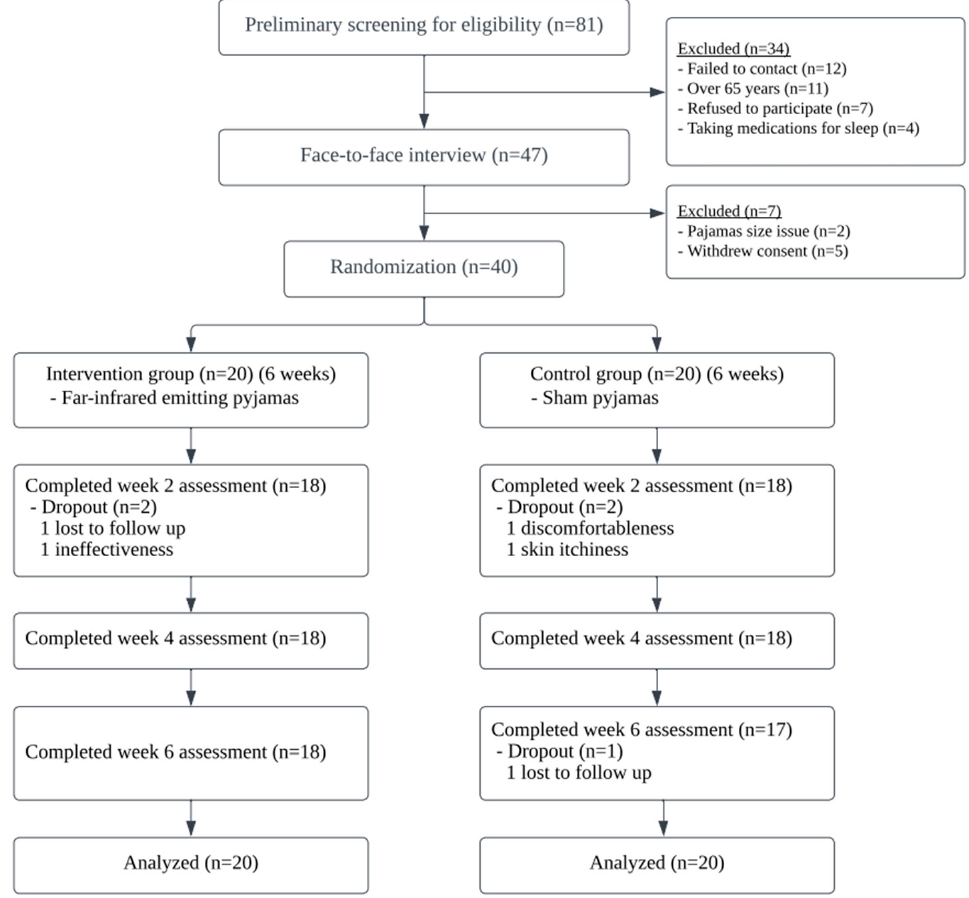
Figure 2. The CONSORT flowchart.